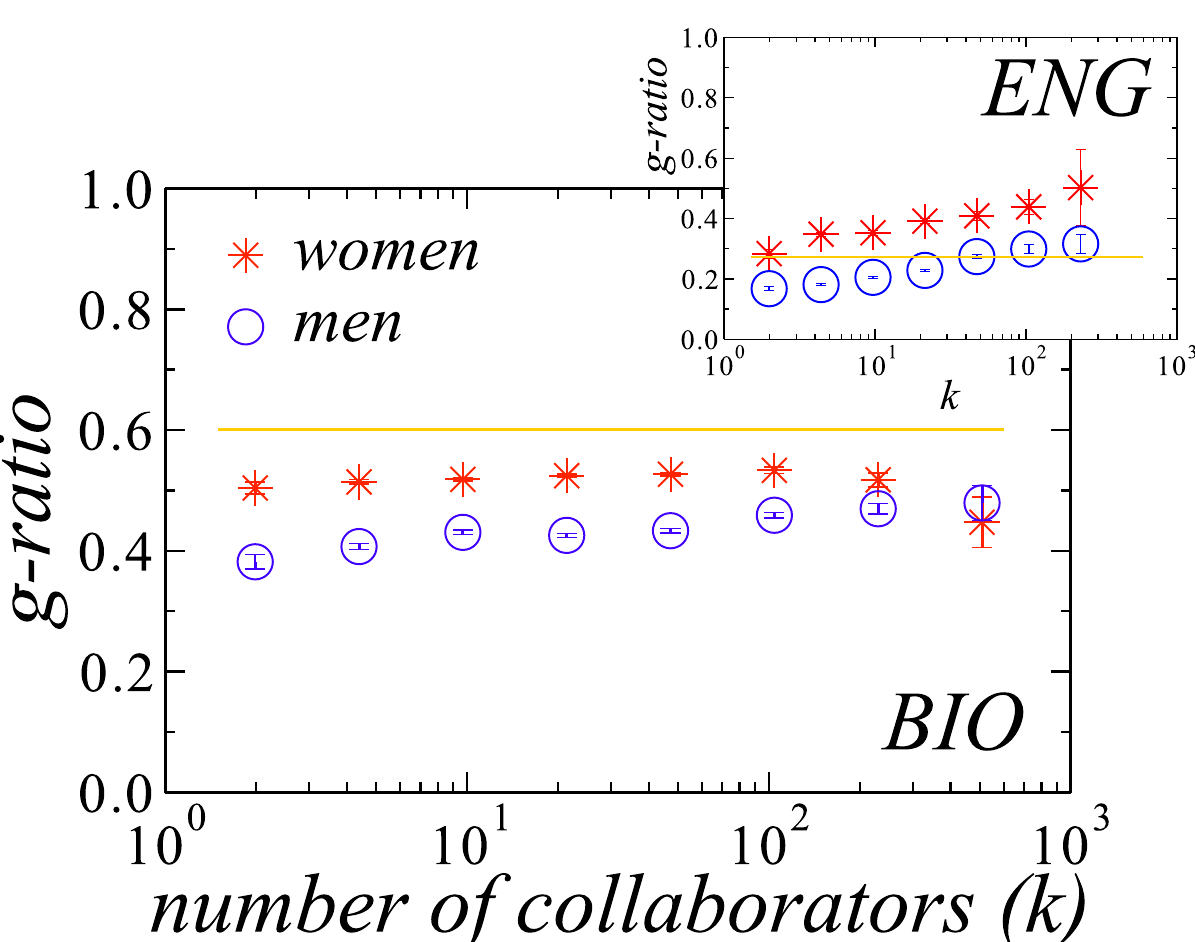
Fig 3. Relation between the g-ratio and the number of collaborators for Biological Sciences (BIO, main plot) and Engineering (ENG, inset) for women (red stars) and men (blue circles). Lines represent the fraction of women in the respectivefield. Men are more likely to collaborate with other men than with their female peers. For Engineering , the g-ratio is even above the fraction of women in the field. Error bars indicatethe standarderror for each bin.